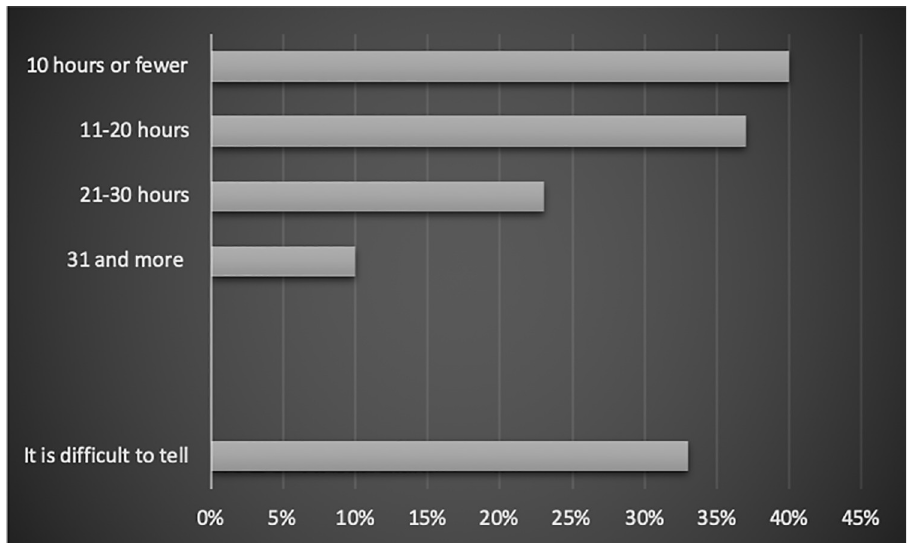
Fig 4. The relation between the time one has at their disposal and employees’ work-life balance (% of people in the category).